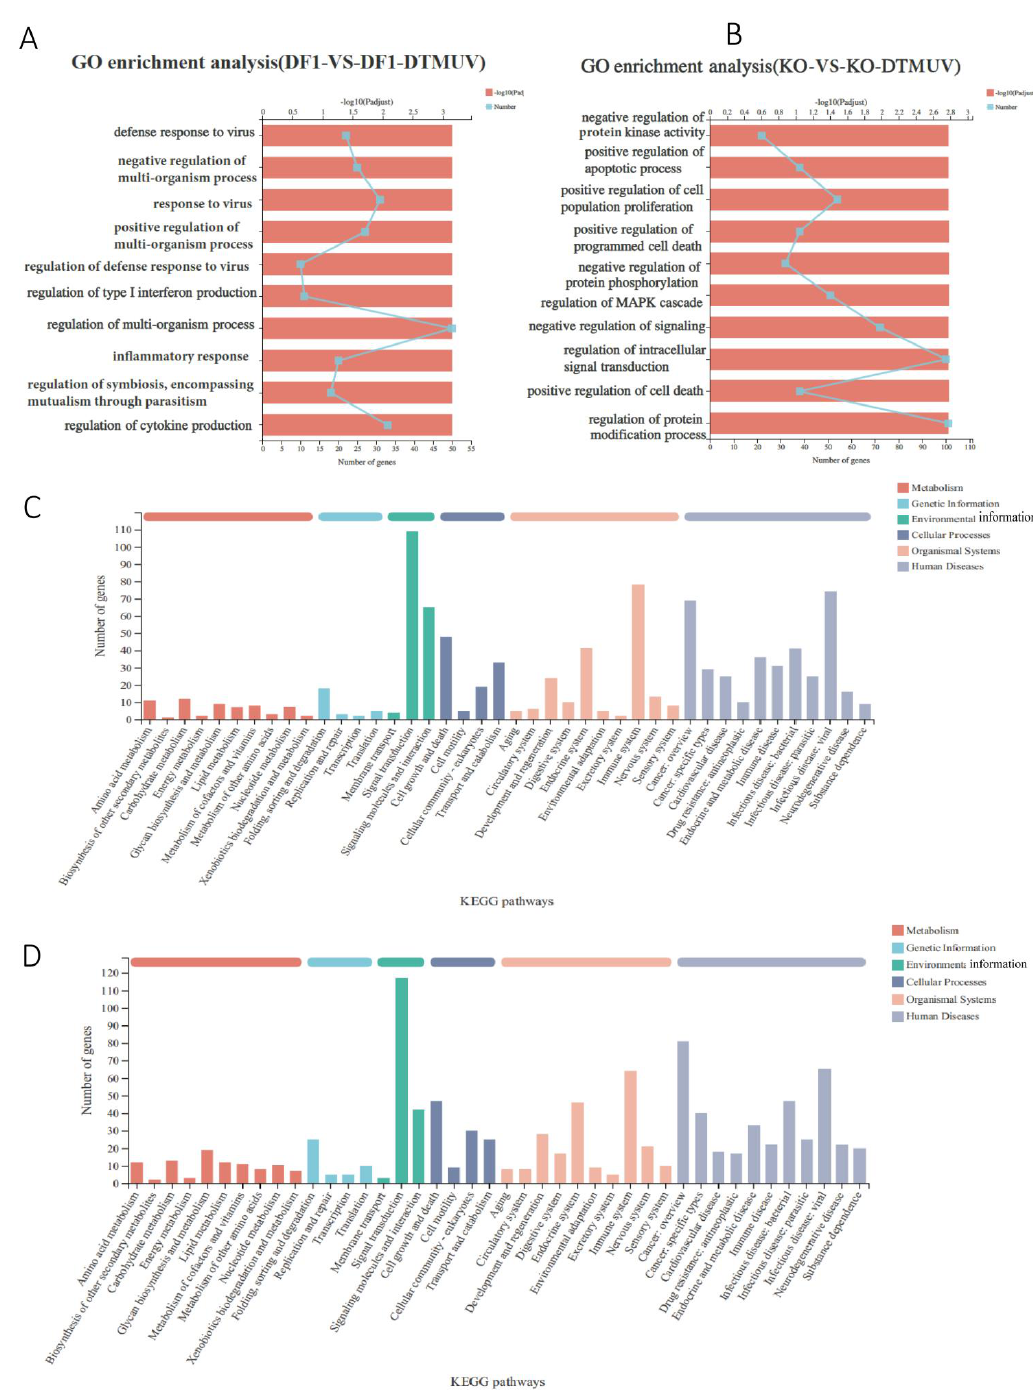
Figure 5. GO enrichment analysis and KEGG analysis of differentially expressed genes in DTMUV— infected DF-1 and KO-IFNAR1 cells. Genes in DF-1 ( A ) and KO-IFNAR1 ( B ) cells induced by DTMUV infection were classified using the GO system. Genes induced by DTMUV infection in DF-1 ( C ) and KO-IFNAR1 ( D ) cells were classified using the KEGG